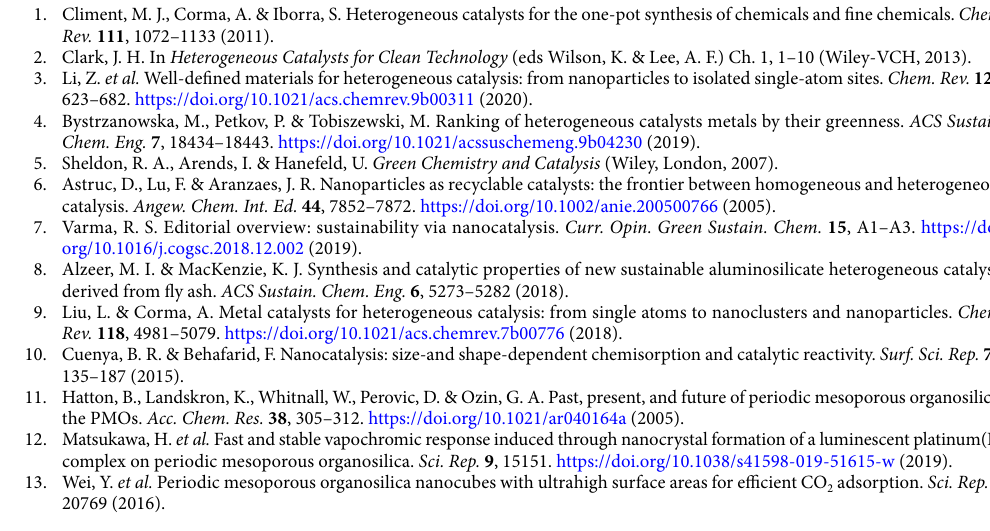
component protocol through condensation of aldehydes, dimedone/malononitrile, and 2-aminobenzimidazole under solvent-free conditions. This methodology offers outstanding advantages including (i) high to excellent yields in shorter reaction times, (ii) low catalyst loading and cost and (iii) simple work-up procedure, fast separa- tion of the catalyst, and catalyst recyclability.